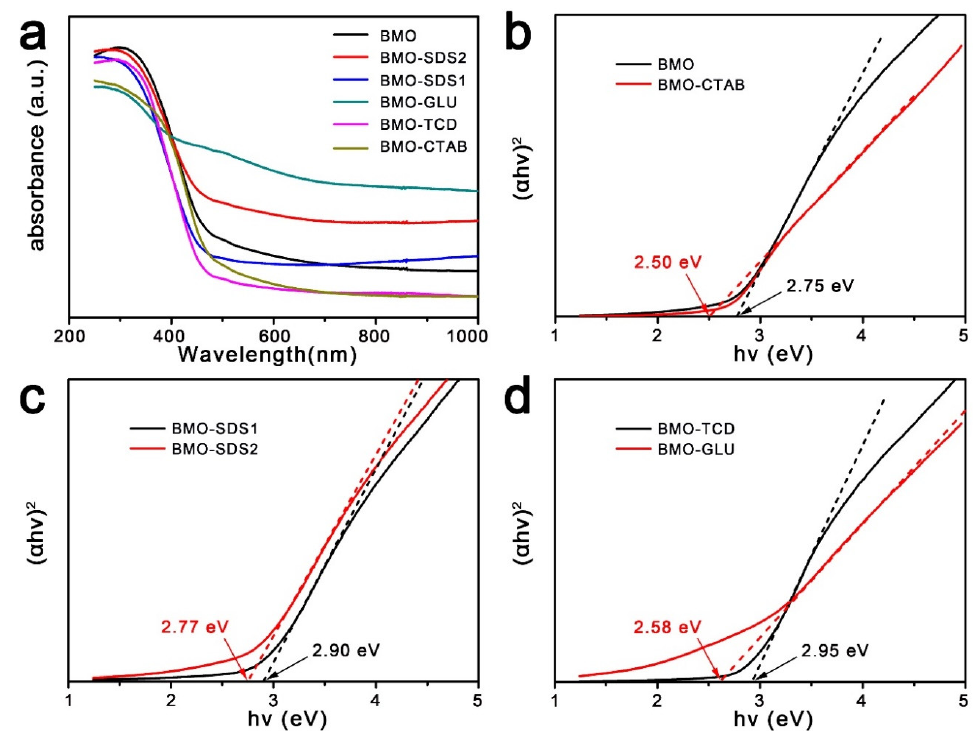
Figure 3. ( a ) UV–Vis-NIR absorption spectra of the Bi 2 MoO 6 samples. ( α h ν ) 2 versus h ν plots for the samples of BMO and BMO-CTAB ( b ), BMO-SDS1 and BMO-SDS2 ( c ), BMO-TCD and BMO-GLU ( d ).